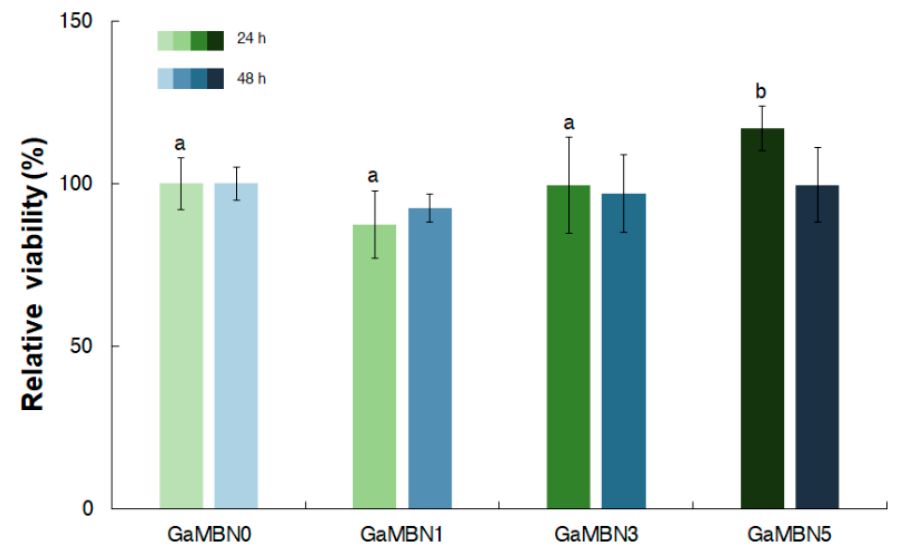
Figure 10. Cell viability of human dental pulp stem cells (hDPSCs) on GaMBN-resin disks after 24 and 48 h. Based on one-way ANOVA (p > 0.01), the results were not significantly different at 48 h. Error bars represent the standard error (n = 7).